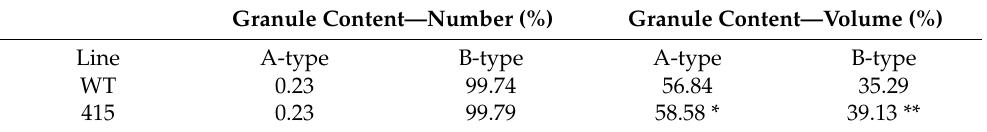
Figure 5. Starch granule structure in the parental WT and mutant M3-415 lines analyzed via SEM. The red and blue arrows indicate the A-type and B-type starch granules, respectively. Table 3. Statistical analysis of starch granule